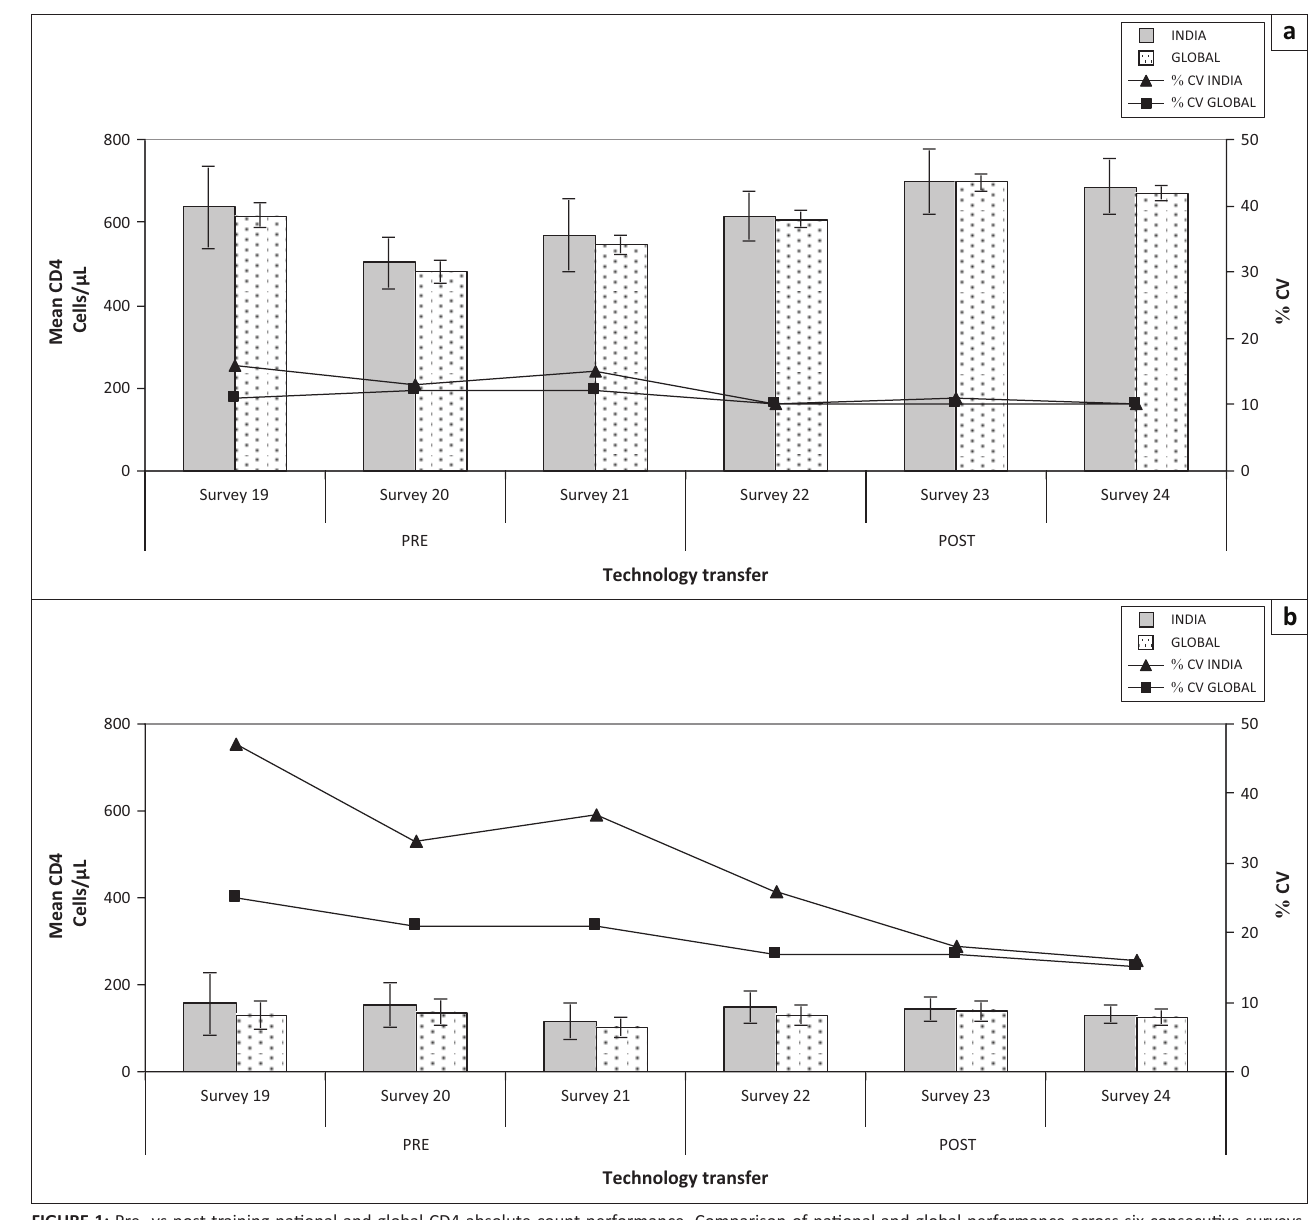
FIGURE 1: Pre- vs post-training national and global CD4 absolute count performance. Comparison of national and global performance across six consecutive surveys, reflecting the impact of technology transfer provided by both QASI and NARI between surveys 21 and 22. Pre-technology transfer reflects QASI sessions 19 through 21 (October 2008, February 2009, June 2009). QASI advanced workshop training was held in September 2009 at NARI in Pune, India. Post-technology transfer reflects QASI sessions 22 through 24 (October 2009, February 2010, June 2010). Group mean CD4 count, standard deviation (error bars) and % CV are illustrated for mid-level (a) and low-level (b) CD4 count controls. Note the drop in % CV for India from 14.7 % to 10.3 % (a) and from 39.0 % to 20.0 %